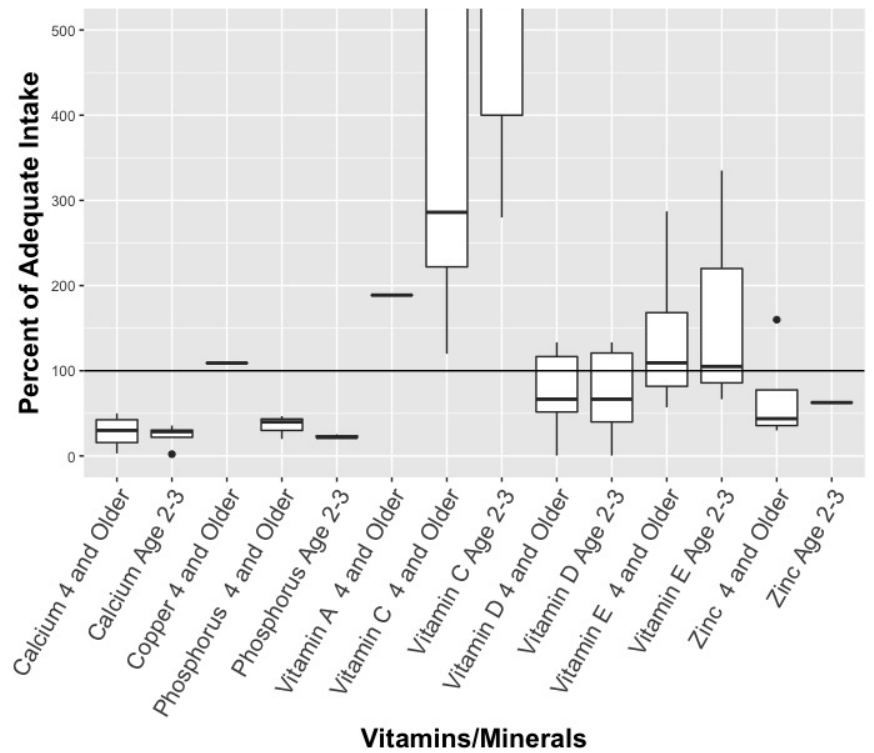
Figure 3. Percent of recommended vitamins/minerals for 2–3 year old and children ages 4+ in non-multivitamin supplements. * Solid line represents median estimate, with top and bottom of box representing quartiles (if sufficient data). Y—axis was truncated at 1000% to allow appropriate visualization of the estimates.